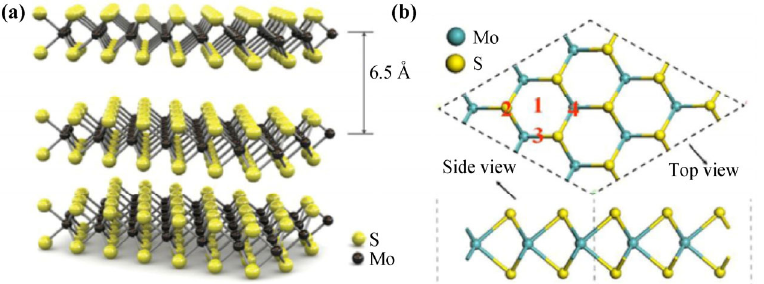
Fig. 4 (a) Three-dimensional representation of the structure of MoS 2 . Single layers, 6.5 Å thick, can be extracted using scotch tape-based micromechanical cleavage. (b) Optimized structures of MoS 2 monolayer with four adsorption sites: (1) hollow site, (2) top site of the S atom, (3) Mo-S bridge site, and (4) top site of the Mo atom